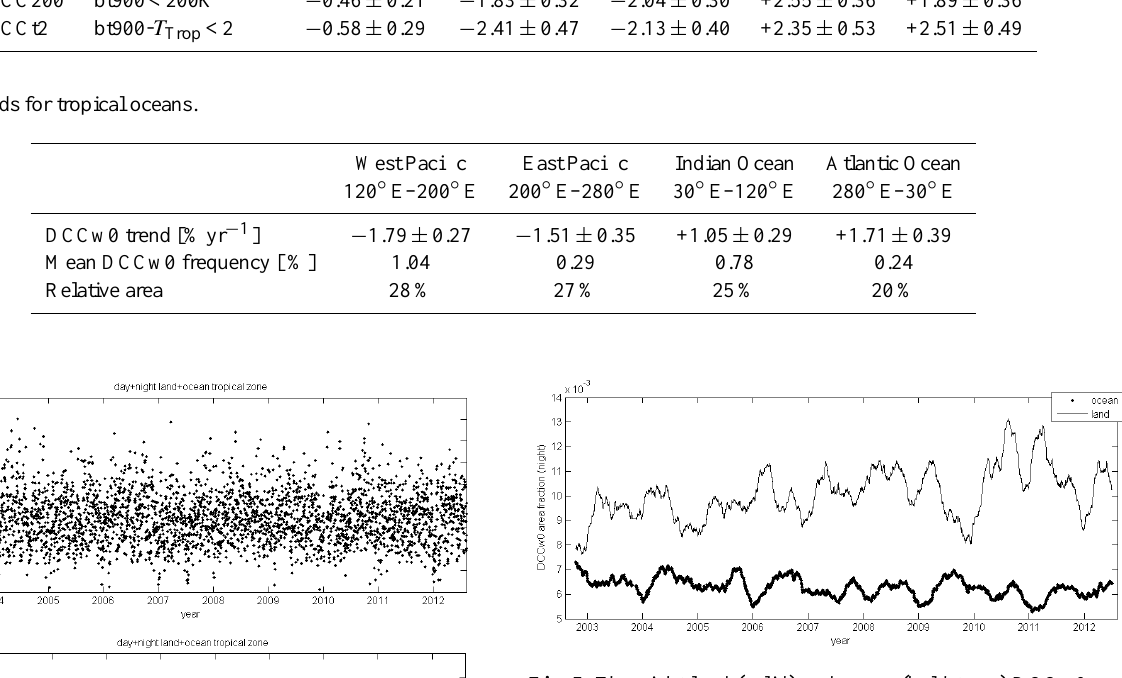
Figure 5. The night land (solid) and ocean (bold trace) DCCw0 area fractions as function of time, 675 Fig. 5. The night land (solid) and ocean (bold trace) DCCw0 area smoothed with a 96-day running average. 676 fractions as function of